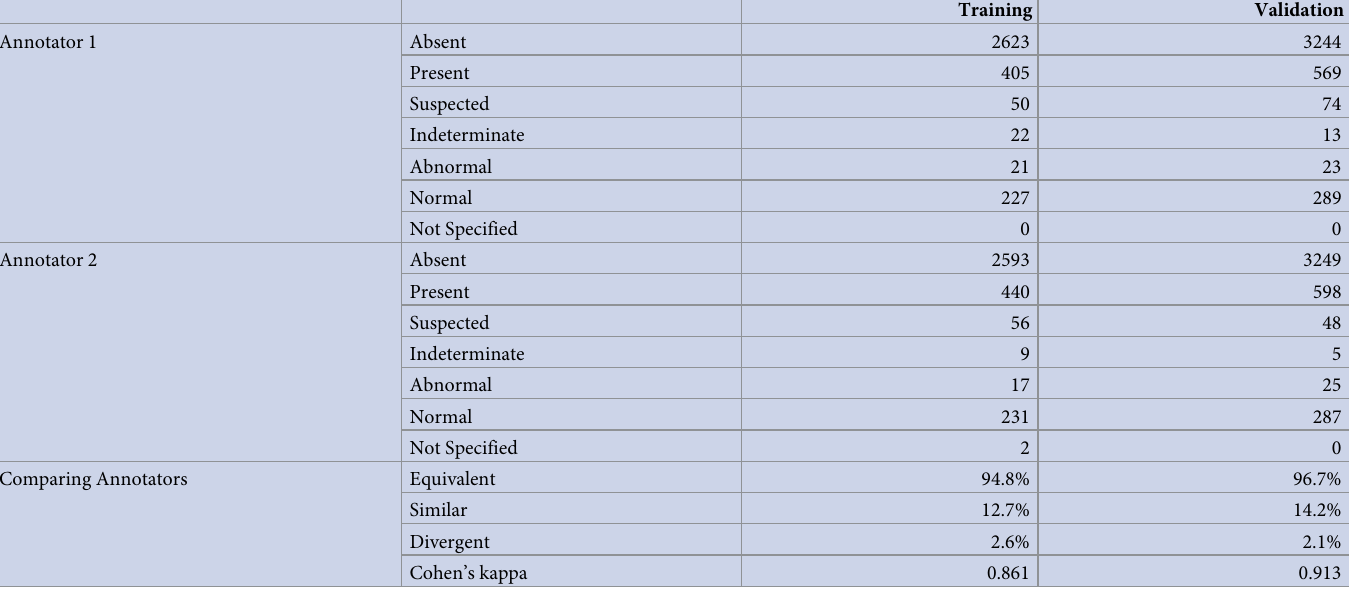
Table 2. Physician annotator